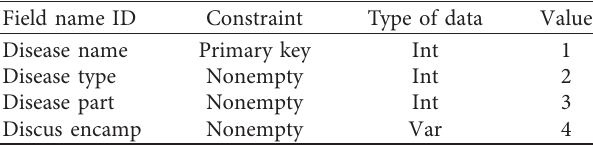
Table 1: Information